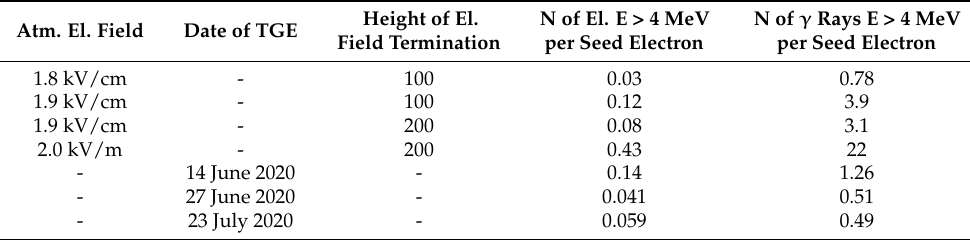
Table 1. Parameters of simulated RREAs, calculated with CORSIKA code, and of three TGEs observed in 2020 (last three